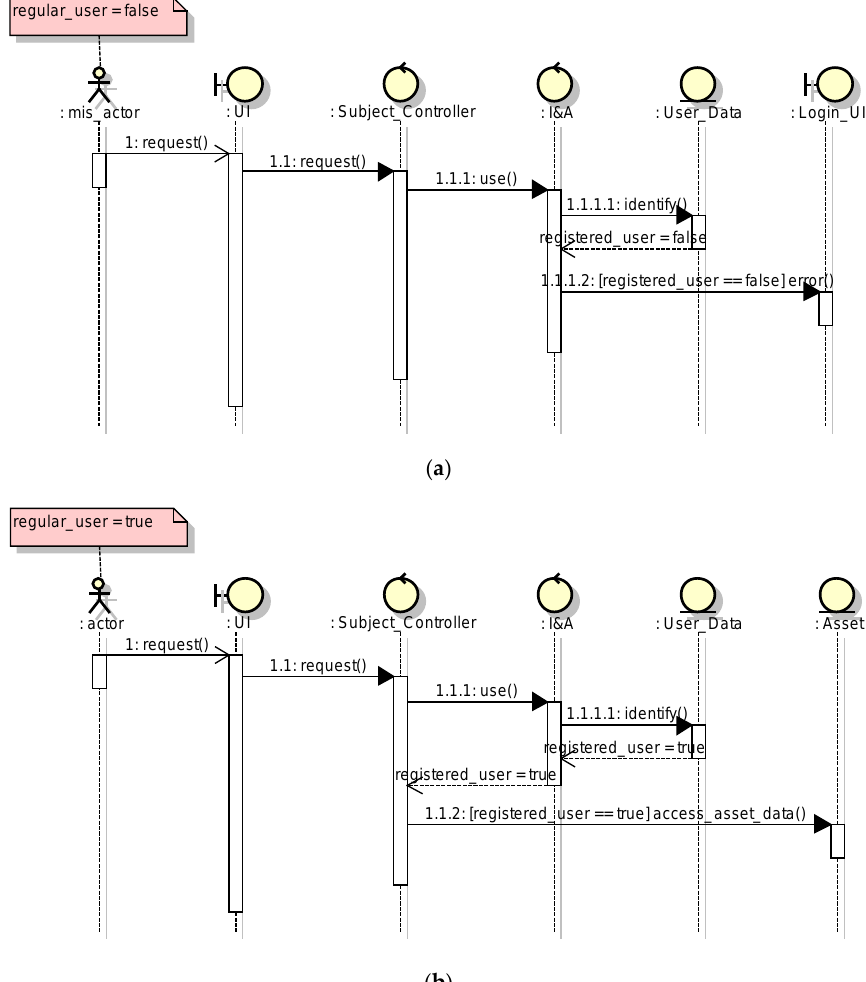
Figure 4. Behavior to access an asset (Password Design and Use pattern). ( a ) Failure case; ( b ) Success case.